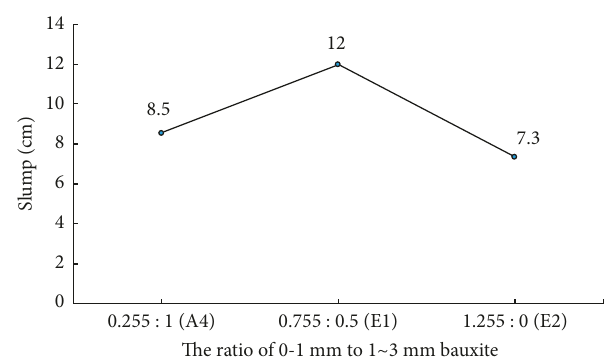
Figure 12: Influence of the amount of different particle sizes of sintered bauxite on the fluidity of UHPFRC.